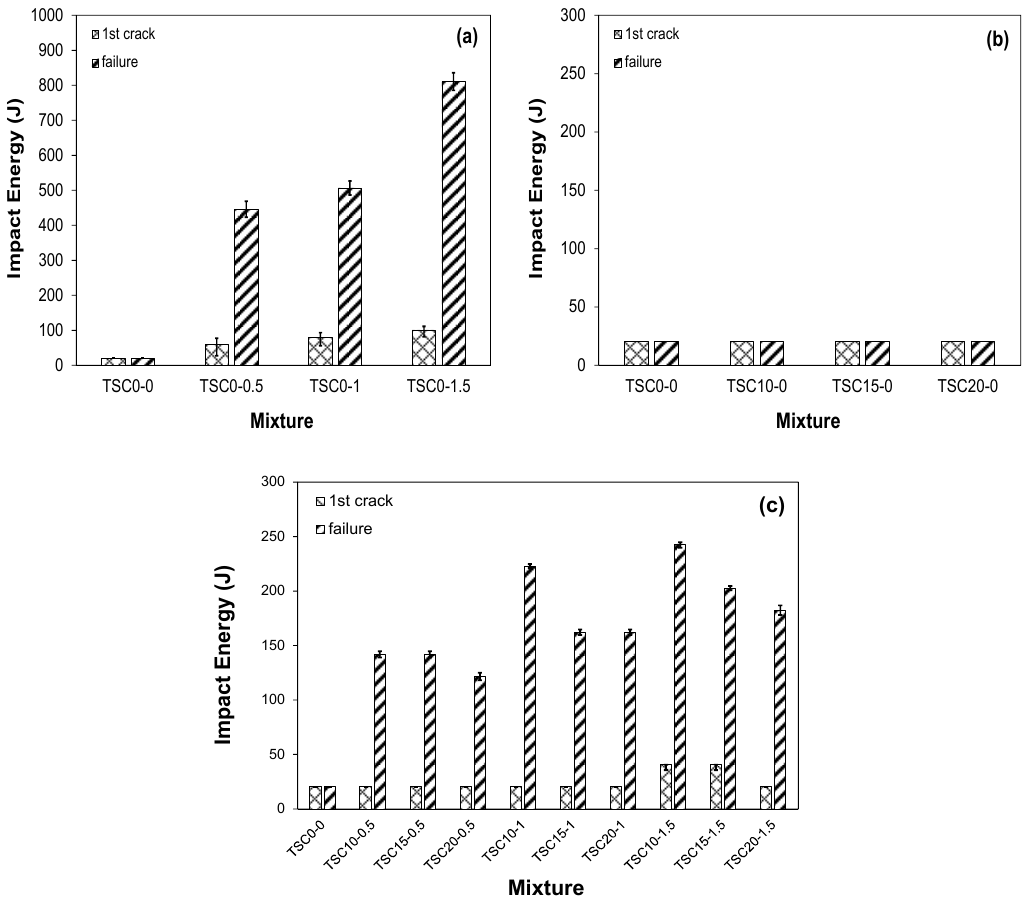
Figure 8. Impact energy sustained by different TSC specimens: ( a ) steel wires, ( b ) tire rubber, and ( c ) combined steel wire and tire rubber.